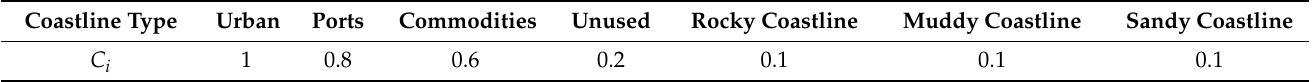
Table 3. The intensity of human activities on different